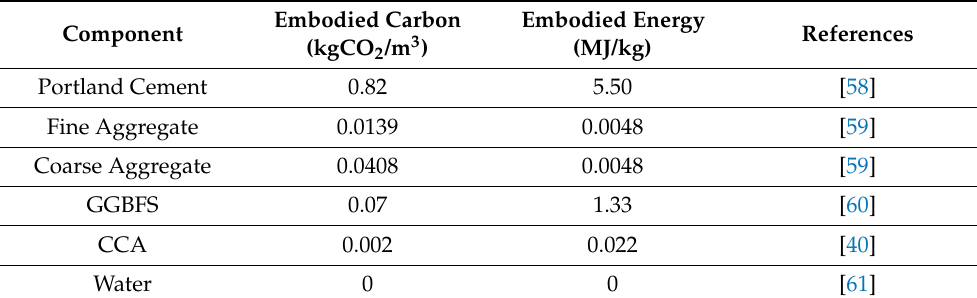
Table 4. Embodied carbon and energy of concrete components.